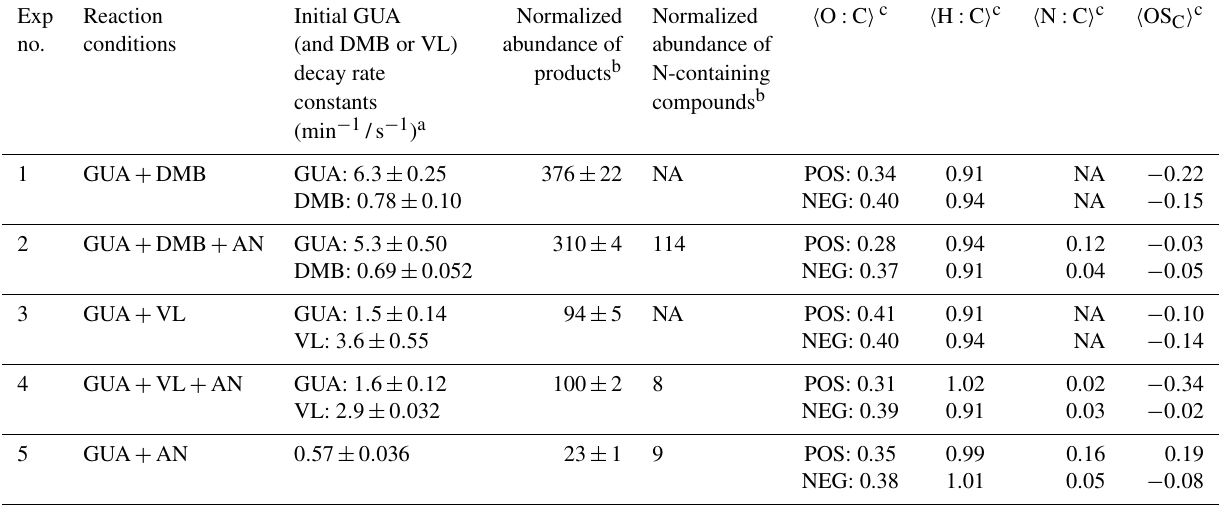
Table 1. Reaction conditions, initial GUA (and DMB or VL) decay rate constants, normalized abundance of products, average elemental ratios, and average carbon oxidation state ( (cid:104) OS C (cid:105) ) in each experiment. The reaction systems consisted of GUA (0.1mM), DMB (0.01mM), VL (0.01mM), and AN (1mM) under air-saturated conditions after 180min of simulated sunlight irradiation. The UHPLC-HESI-Orbitrap- MS data were obtained in both positive (POS) and negative (NEG) ion modes.